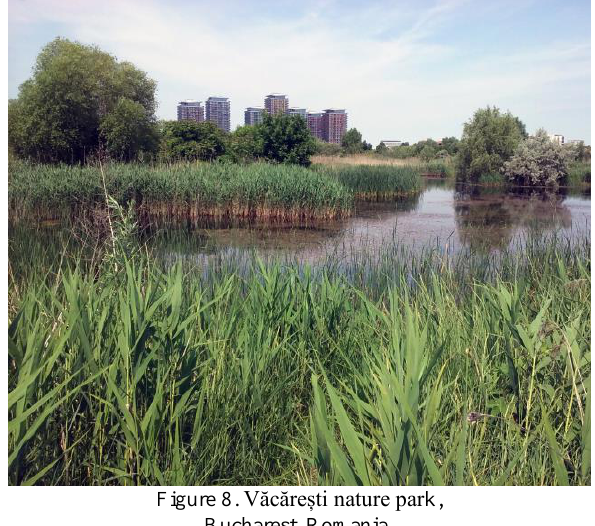
Figure 8. Văcărești nature park, Bucharest,